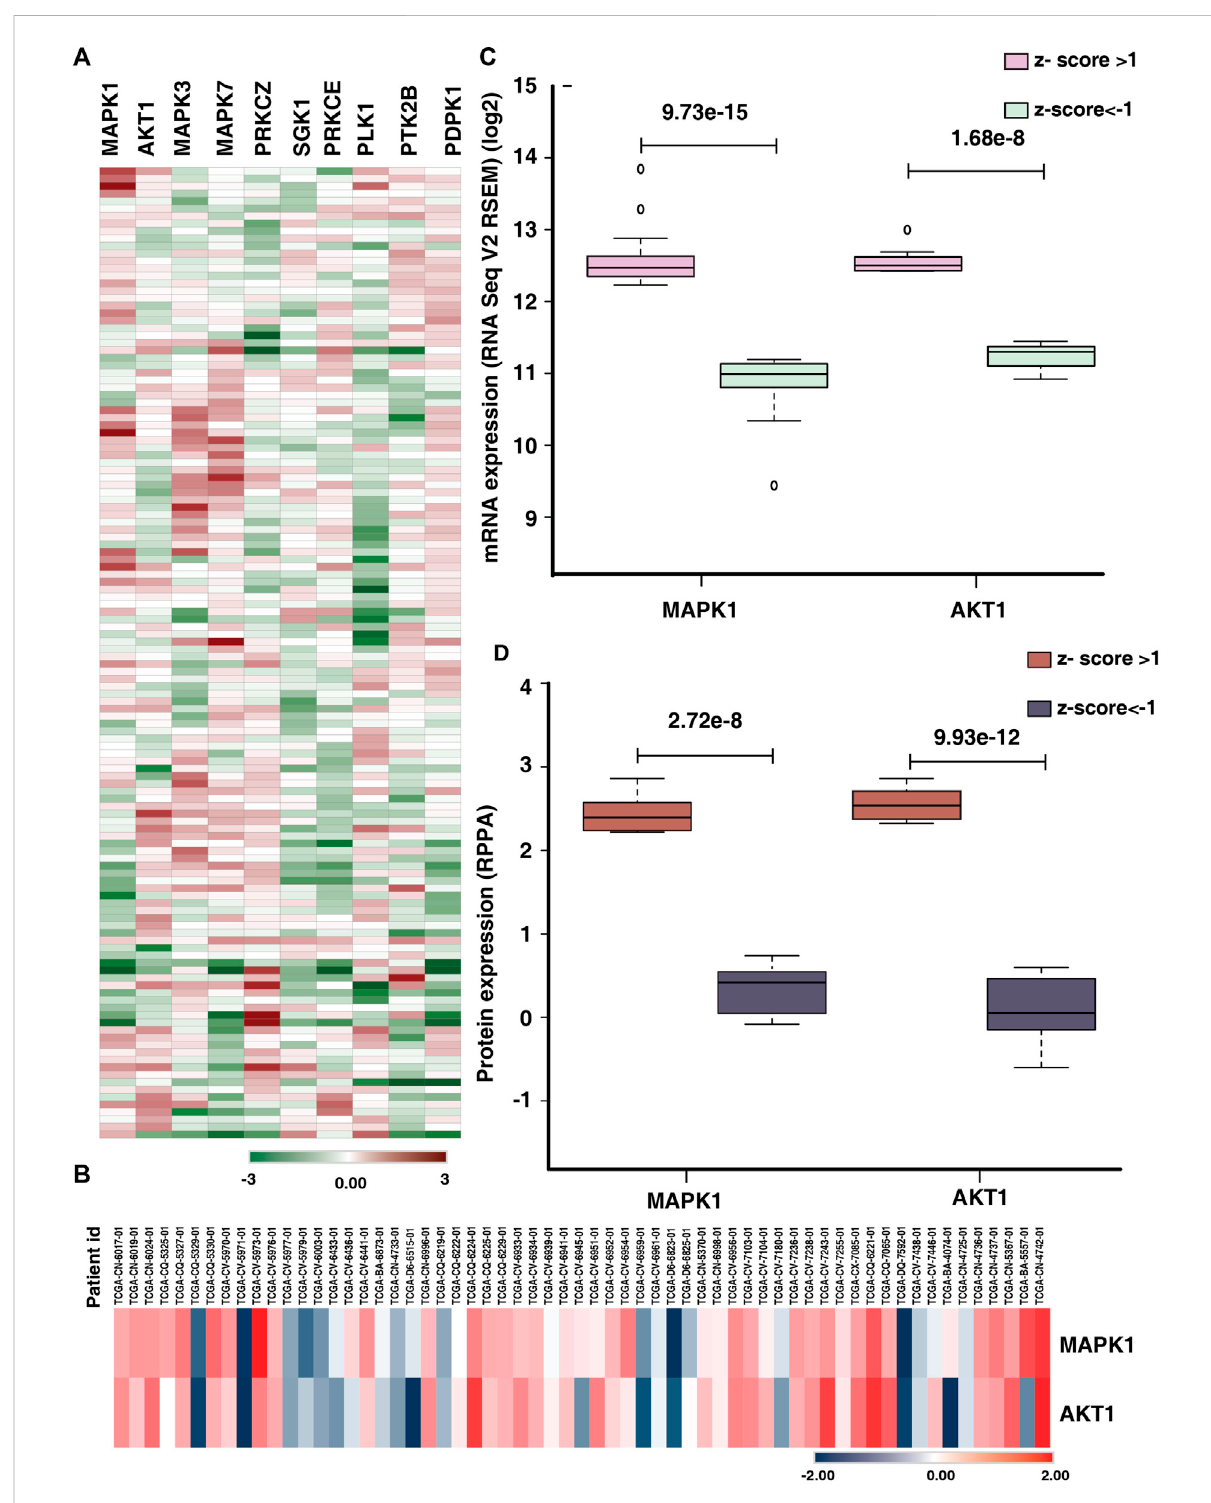
FIGURE 6 Comparison of expression of predicted kinases in publicly available data. (A) Heat map representing the mRNA expression (z-score) of top ten predictedkinasesintonguecancerpatients(131patients)inthestudyHeadandNeckSquamousCellCarcinoma(TCGA,FirehoseLegacy). (B) Protein expression (z-score) of the kinases MAPK1 and AKT1 of tongue cancer patients (RPPA data). (C) Comparison of the mRNA expression of top two predicted kinases (MAPK1 and AKT1) between the upregulated (z-score > 1) and downregulated groups (z-score < -1). (D) Box plot representing thesigni fi cantdifference inproteinexpression oftoptwopredicted kinases(MAPK1andAKT1)inupregulatedgroup(z-score > 1)anddown regulated group (z-score <